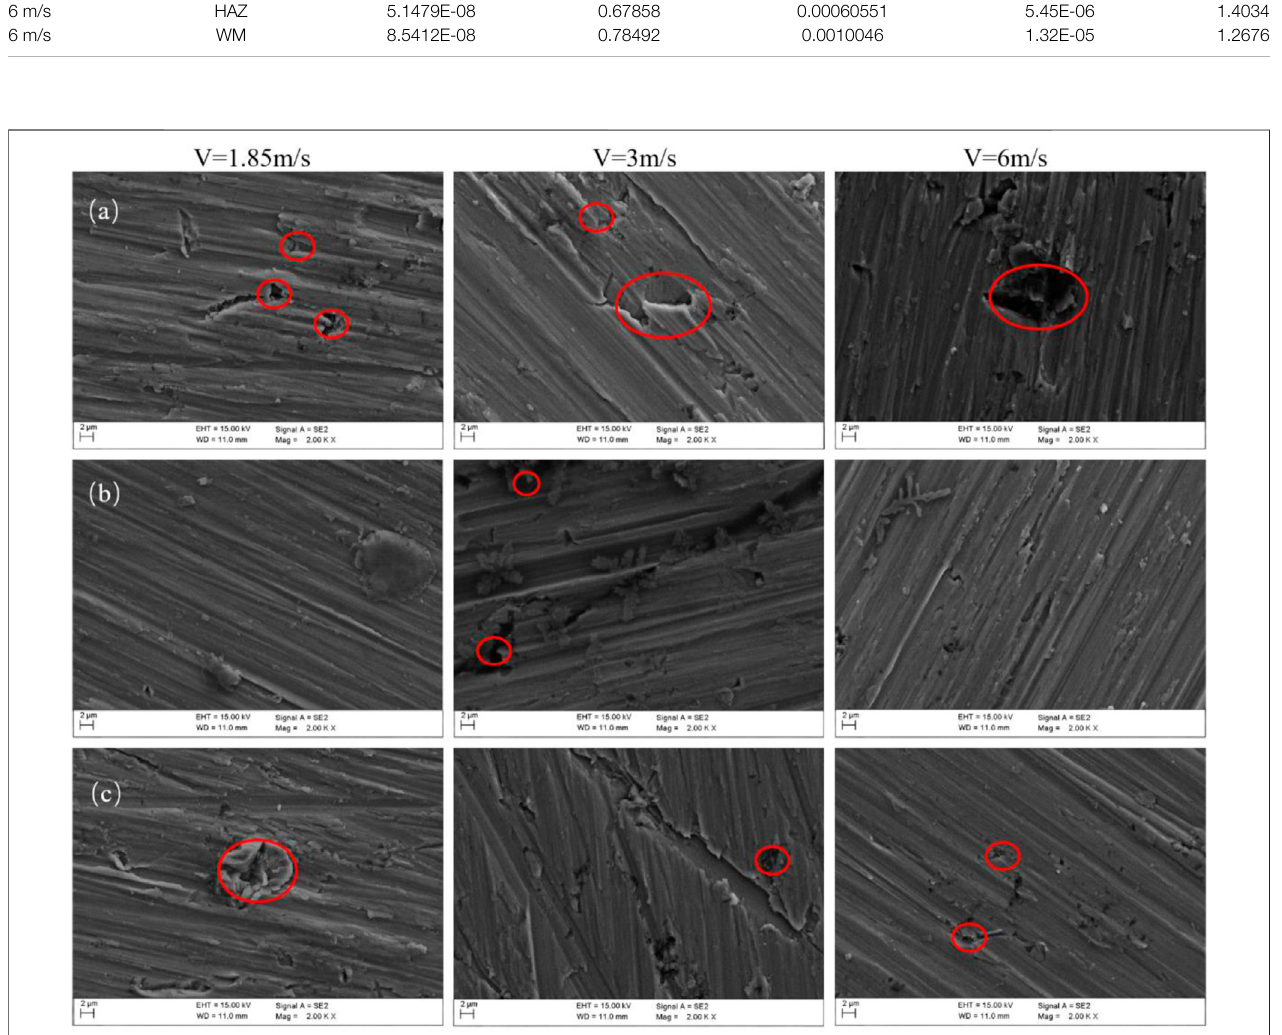
Frontiers in Materials |